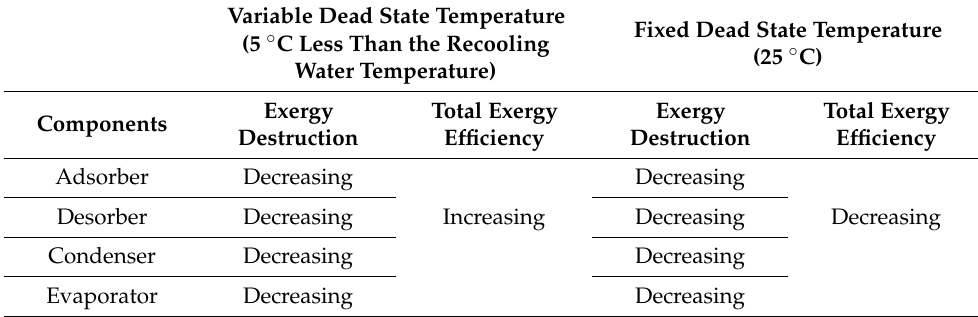
Figure 12. Exergy destruction in the desorber, adsorber, condenser, and evaporator at fixed and variable dead state temperatures. Table 1. Effect of recooling water increase on the exergy destruction and